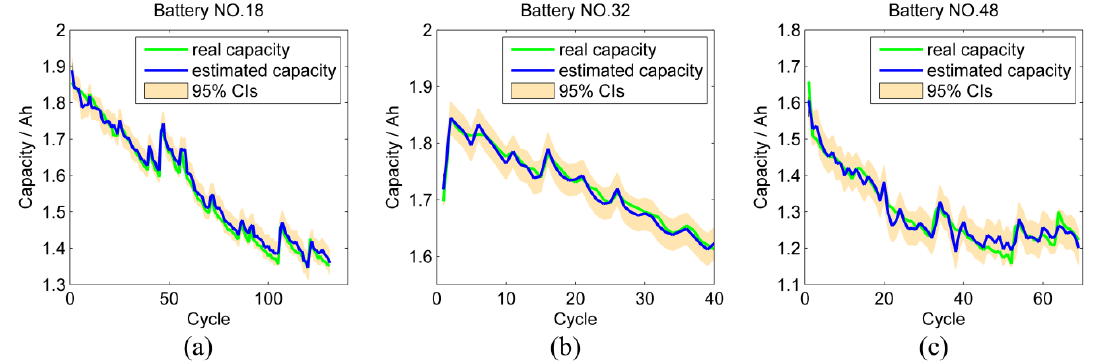
Figure 7. Online capacity estimation results: ( a ) Battery 18; ( b ) Battery 32; ( c ) Battery 48.